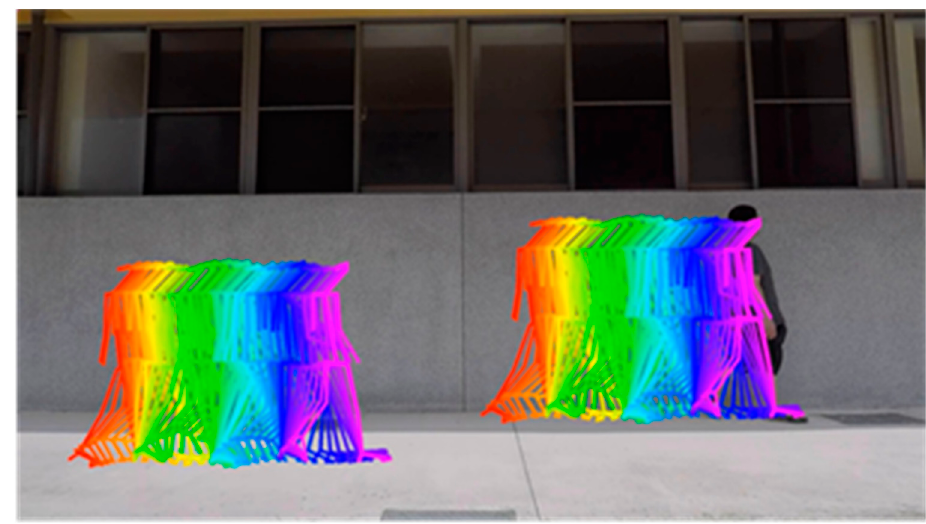
Figure 7. Schematic diagram before and after normalization.